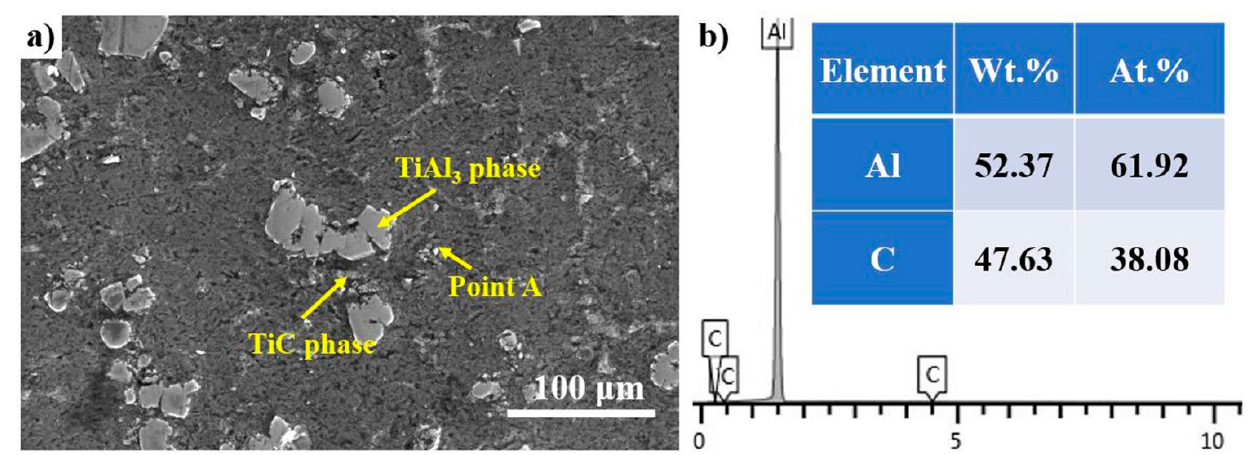
Figure 7. ( a ) Secondary electron image of TiAl 3 and Al 4 C 3 ; and ( b ) the EDS spectrums of point A.